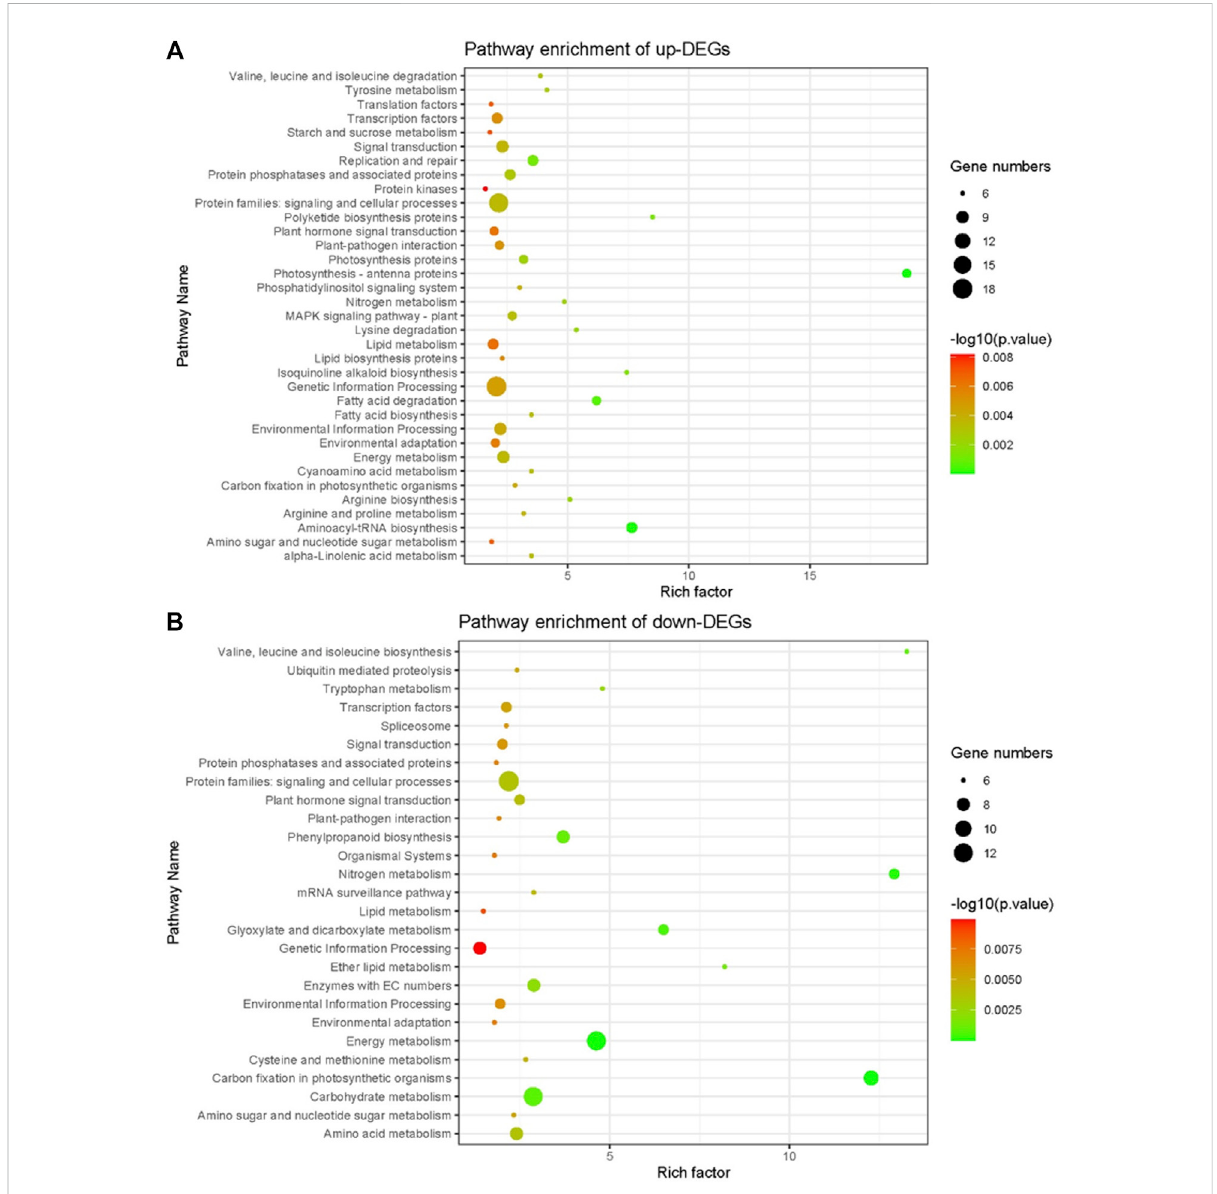
FIGURE 7 KEGG pathway enrichment of differentially expressed genes between NIL176 and Guichao 2. (A) : KEGG pathway enrichment of up-regulated genes in NIL176 compared with Guichao 2. (B) : KEGG pathway enrichment of down-regulated genes in NIL176 compared with Guichao